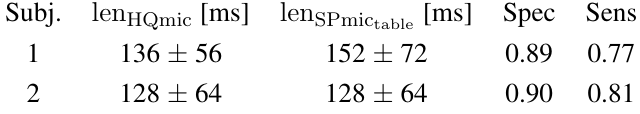
Table 2. GTal, microphones comparison: correlation coefficients between features extracted from the audio acquired with the HQmic and SPmic segments. The corresponding p -values are shown in